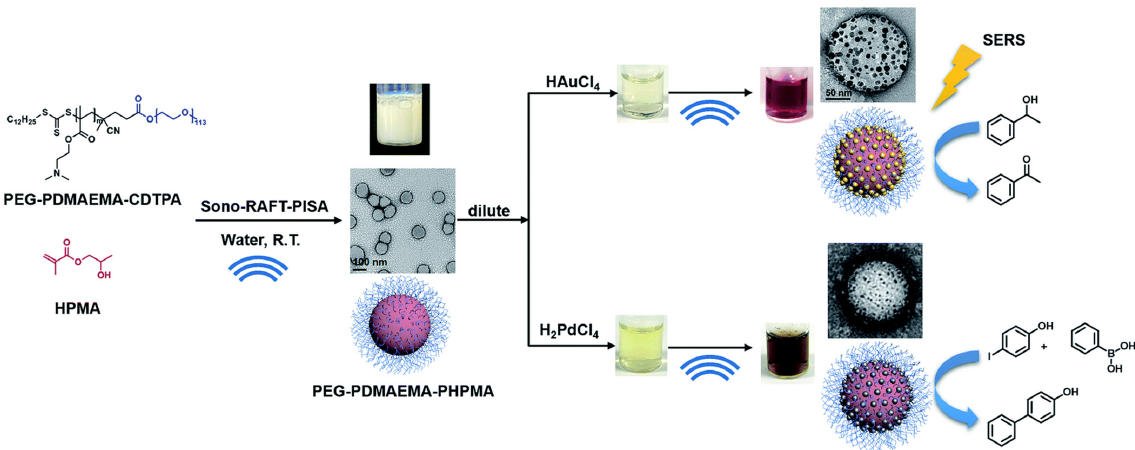
Figure 7. Synthesis of tertiary amine-containing polymeric nanoparticles, and in situ formation of the Au and Pd nanocomposite by ultrasound. (Adapted with permission from Ref. [233]. 2021, Wan